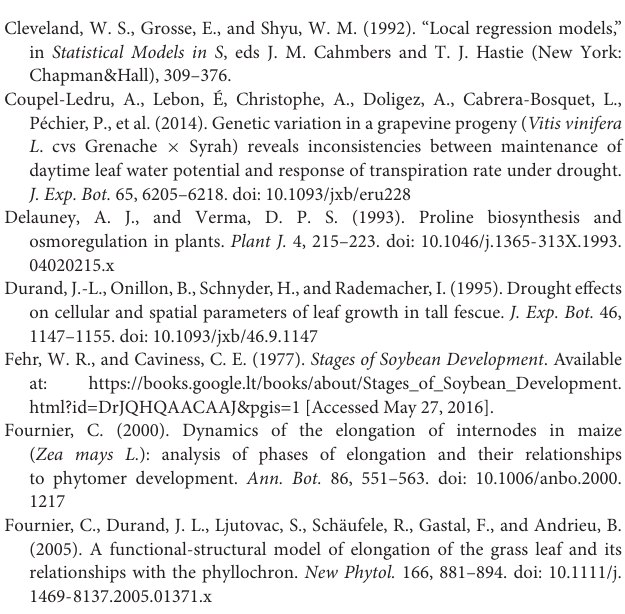
FIGURE S1 | Extension of perennial ryegrass leaves under water deficit conditions. The graph shows leaf length extension (y-axis, mm) of seven leaves using clonal replicates of a single genotype. The x-axis shows the time (h) since the start of the experiment. From time 0 onwards, water was withheld until the re-watering after five days (black line). The growth of individual tillers is shown as colored lines. FIGURE S2 | Relative growth rates of single tillers from 15 clonally replicated plants of the perennial ryegrass genotype Arara A under well-watered conditions. The x-axis shows time (h). The y-axis illustrates the observed leaf elongation rate (LER) divided by the expected growth rate per temperature ( a T). Results are given per hour, shown as a continuous black line. The linear fits of LER/ a T versus time are indicated by the blue line. The averaged data of the 15 tillers indicated that LER/ a T decreased at a rate of 0.005 ( ± 0.002) per